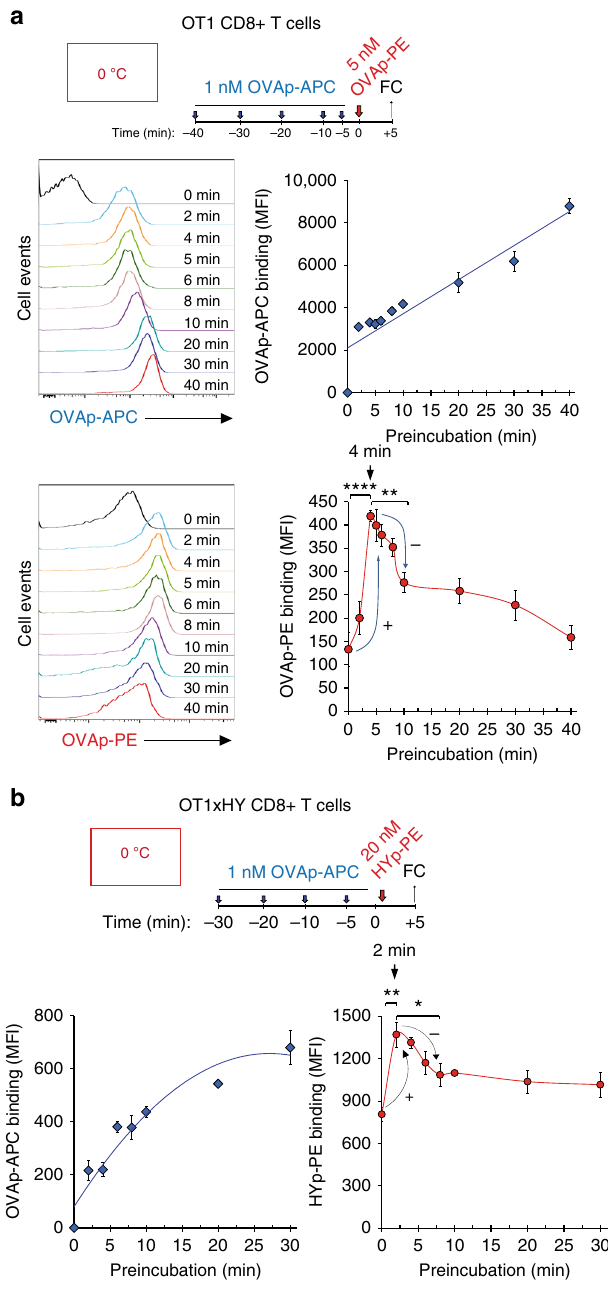
Fig. 3 Binding of a fi rst pMHC tetramer ligand at sub-saturating concentrations transiently favours binding of a second pMHC tetramer ligand. a OT-1 T CD8 + T cells were preincubated at 0 °C with 1 nM OVAp- APC tetramer for the indicated times and subsequently incubated with 5 nM of OVAp-PE tetramer for fi ve additional minutes. Time 0 indicates binding of OVAp-PE tetramer in the absence of preincubation with OVAp- APC tetramer. Cells were fi xed and stained for CD8 before analysis by fl ow cytometry and calculation of the MFI for OVAp-PE and OVAp-APC. Histograms for OVAp-APC tetramers and OVAp-PE tetramer fl uorescence intensity are shown on the left panels. The MFI values for OVAp-APC tetramers and OVAp-PE tetramer are represented on the right panels. b CD8 + T cells from double transgenic female OT-1xHY mice were preincubated on ice with 1 nM OVAp-APC tetramer for the indicated times and subsequently incubated with 20 nM of HYp-PE tetramer for fi ve additional minutes. Cells were fi xed and stained for CD8 before analysis by fl ow cytometry to generate MFI values for HYp-PE and OVAp-APC binding. All data shown in Fig. 3 represent the mean ± s.d. of triplicate datasets; * p < 0.05; ** p < 0.005; **** p < 0.00005 (2-tail unpaired t